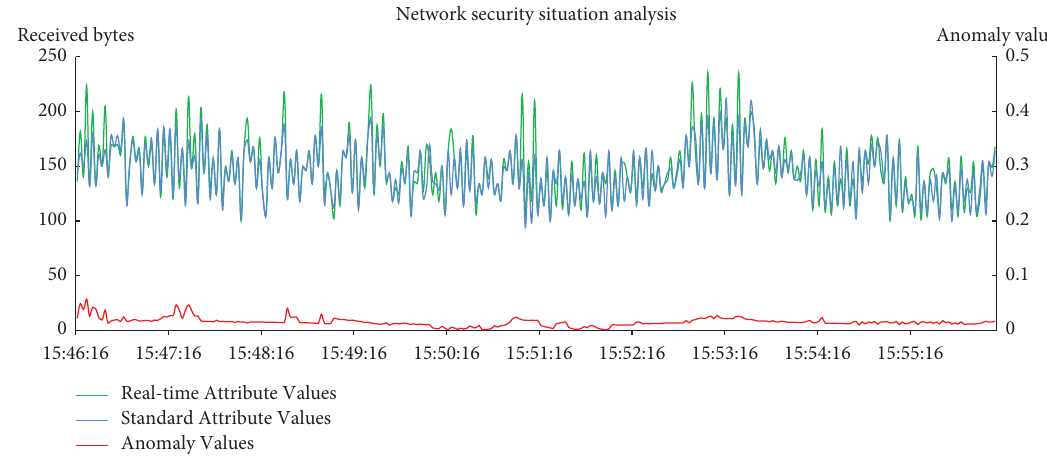
Figure 9: Network security situation analysis of a normal terminal.